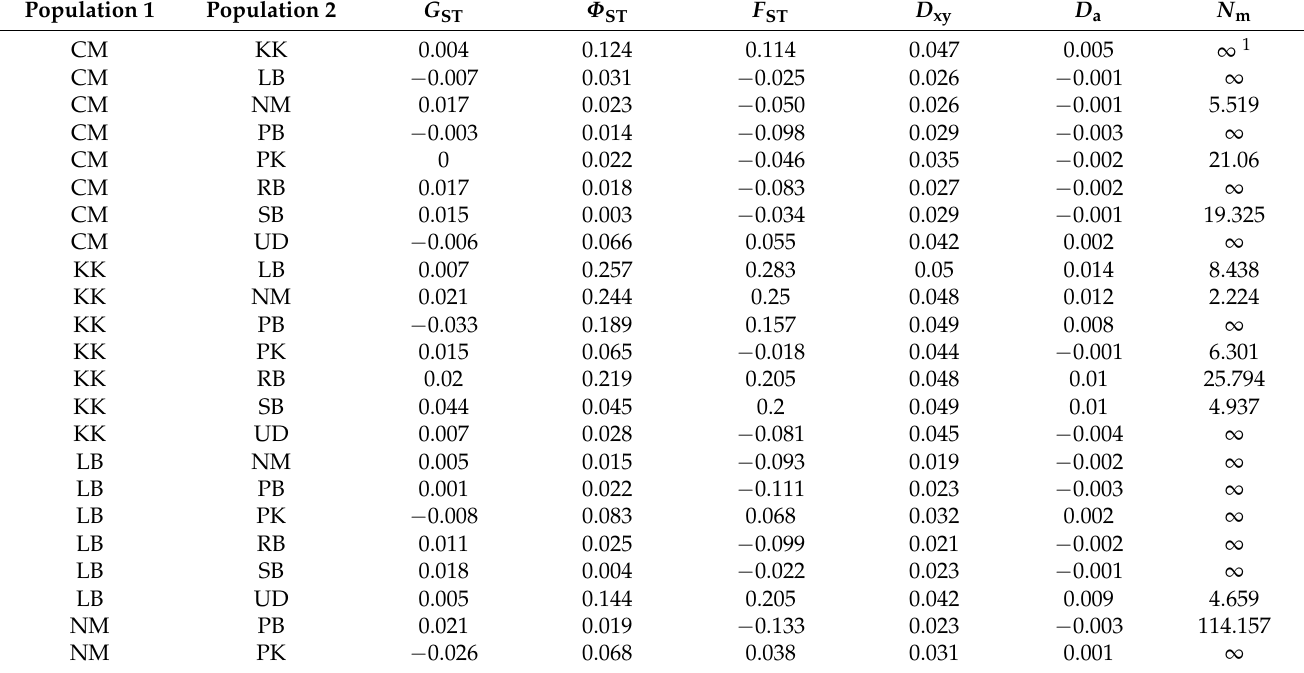
Table 4. Neutrality tests of mitochondrial D-loop sequences from nine cattle populations in Thailand.